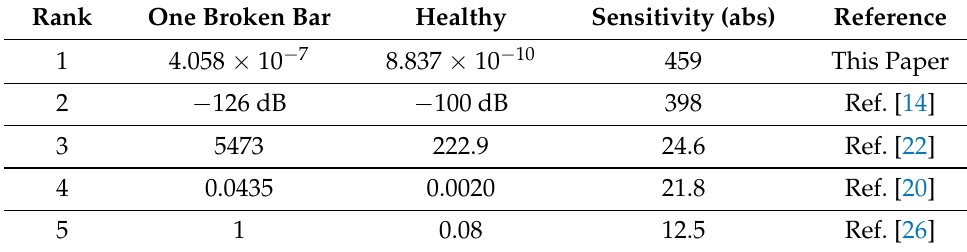
Table 3. Severity Index